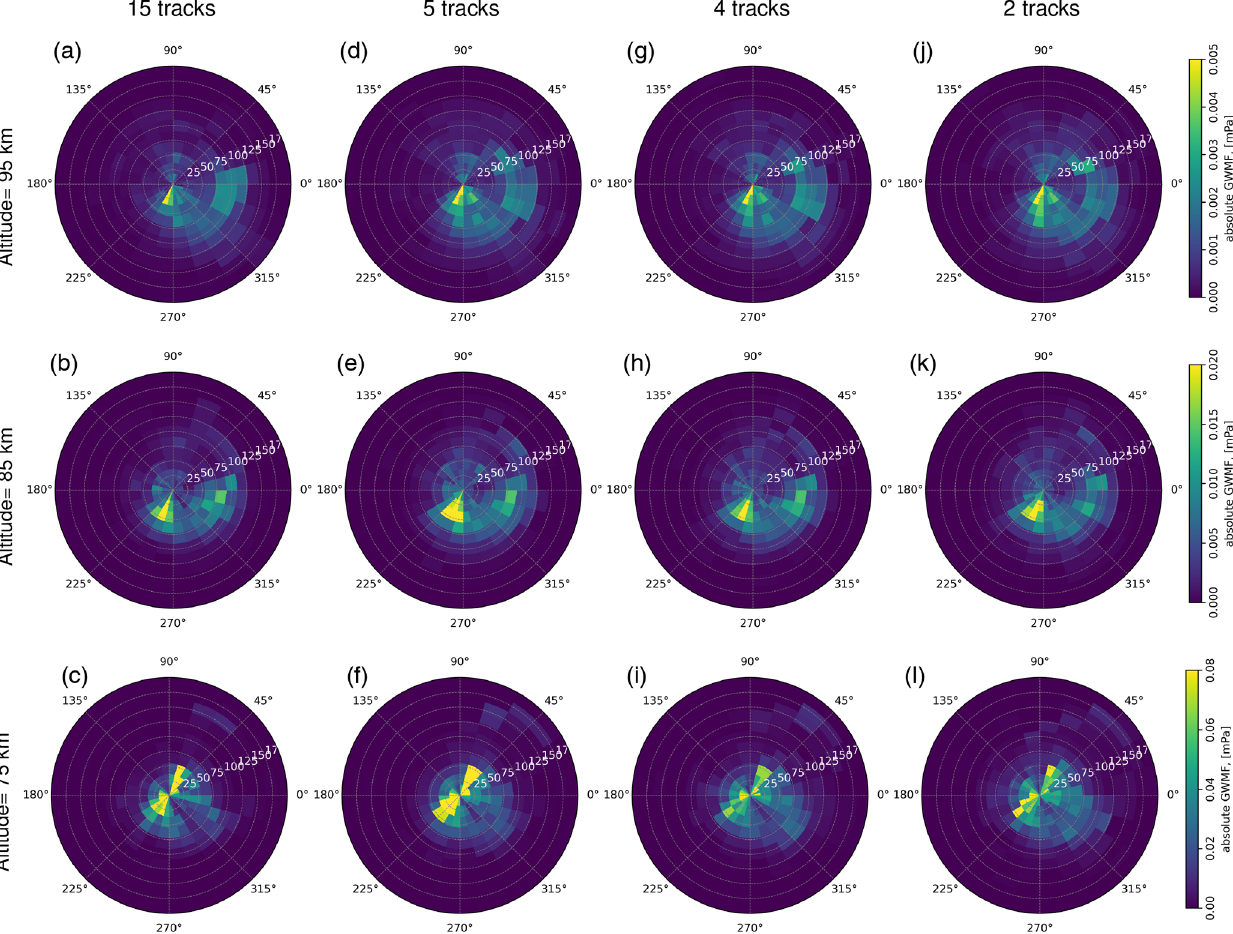
Figure 11. Polar plots of phase speed and direction versus GW pseudomomentum flux in the northern middle and higher latitudes of 40 to 70 ◦ at an altitude of 75km (bottom panels), 85km (middle panels), and 95km (upper panels) in line with the four cases as in Fig. 10. The direction is in azimuth angle by which 0 ◦ is eastward and 90 ◦ is northward. The white dashed radius lines indicate various phase speed values in units of meters per second (ms − 1